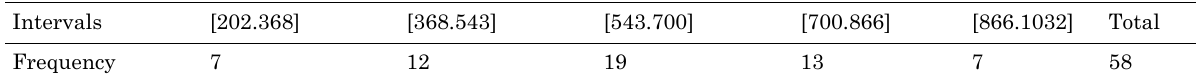
fig. 4. Histogram of the importance of the environment indicators table 11. collective results of the ranking of the importance of the lease indicators